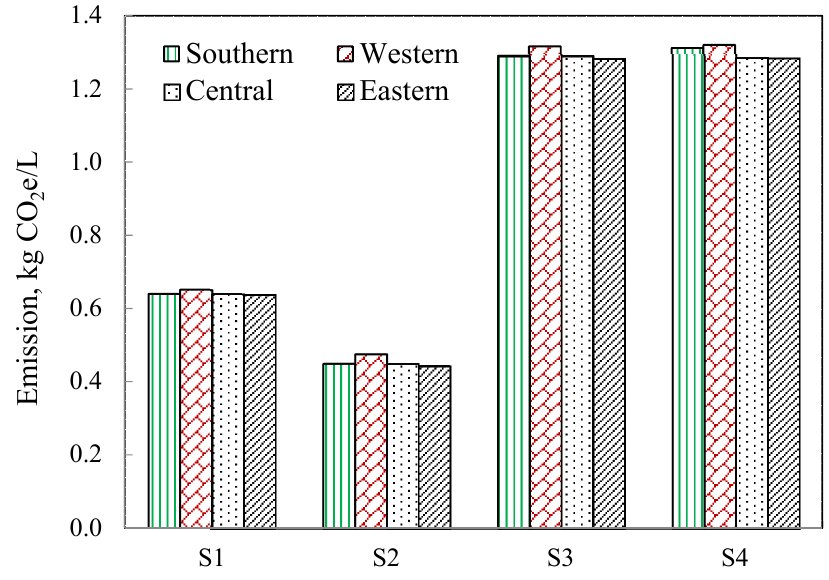
Figure 5. Net emission at different locations in Ontario.